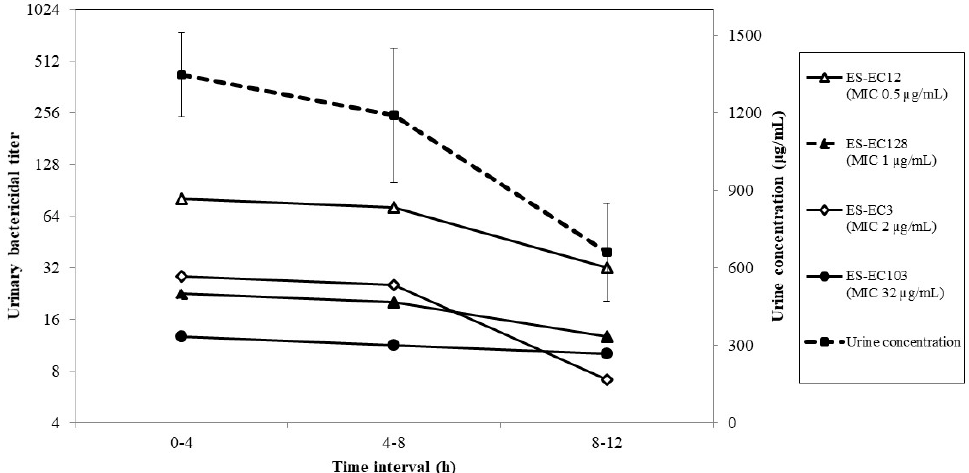
Figure 1. Urinary concentrations and urinary bactericidal titers (UBTs) of fosfomycin in dogs administered a dose of 80 mg/kg body weight (Mean ± SE, n = 6).